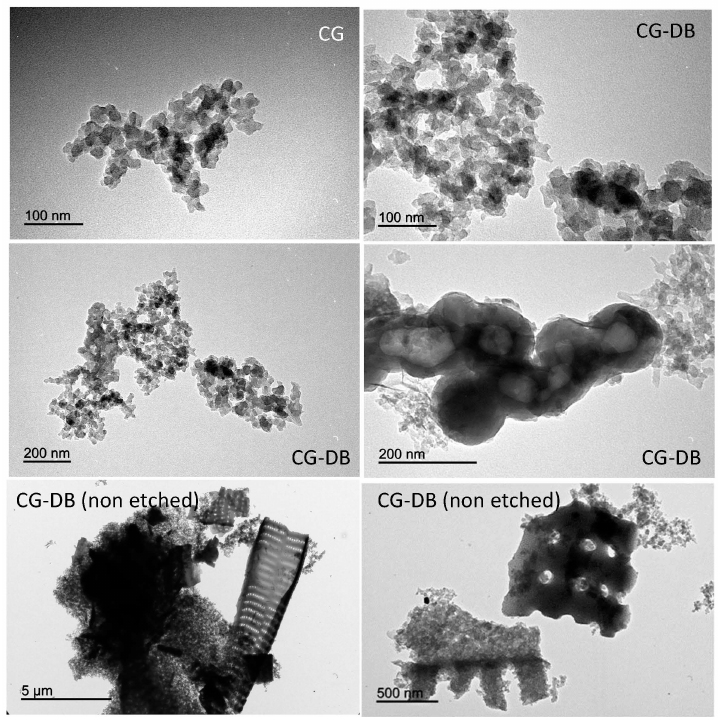
Figure 2. Transmission Electron Microscopy (TEM) images representative of the carbon aerogels showing the presence of the